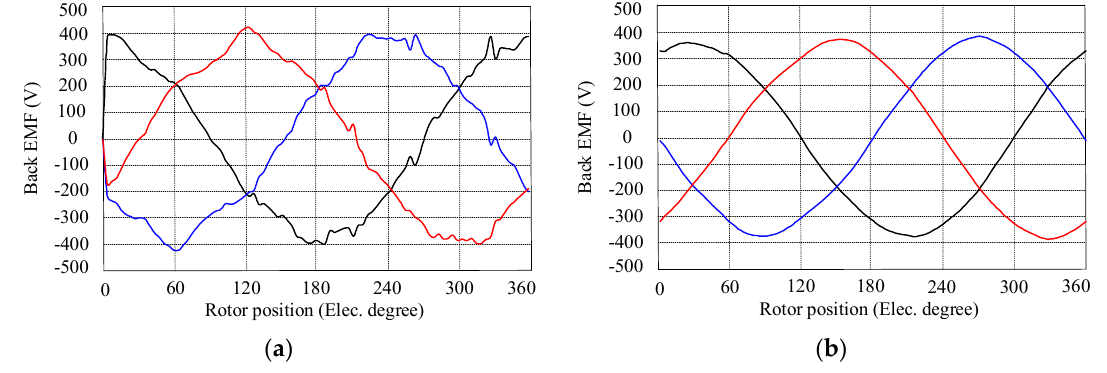
Figure 10. Back electromagnetic force (EMF): ( a ) without skew and ( b ) with skew.